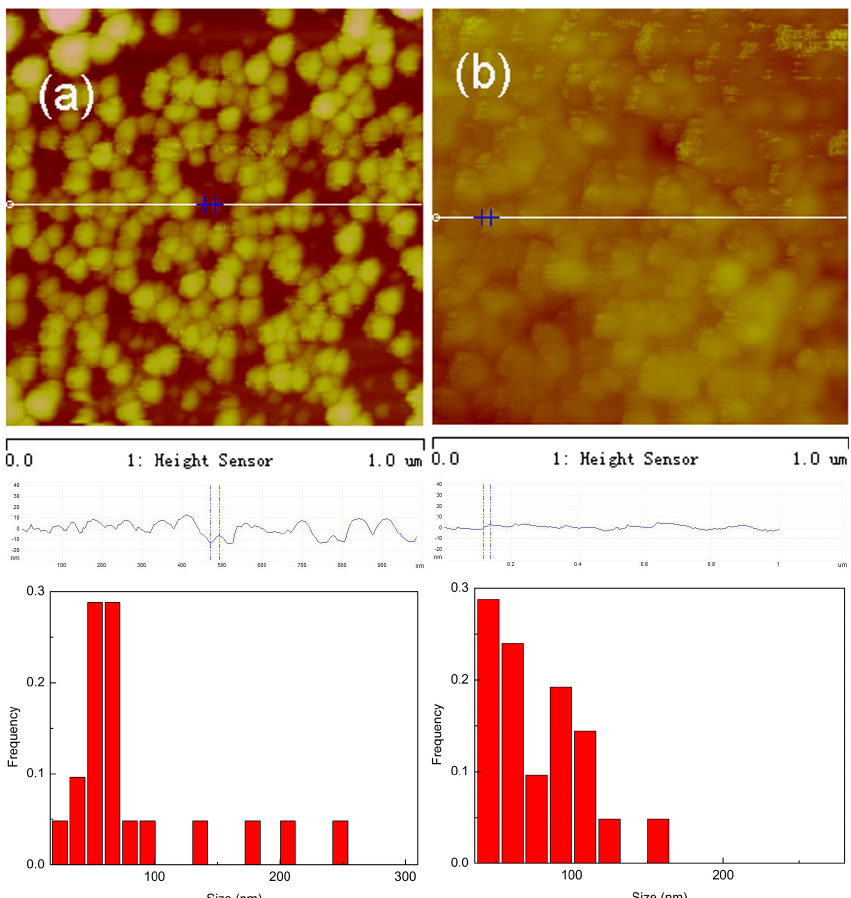
Figure 3: Topography 2D images, high profile diagram and grain size distribution on the surface of Cu 2 O films fabricated by different methods, (a) MOD, (b)